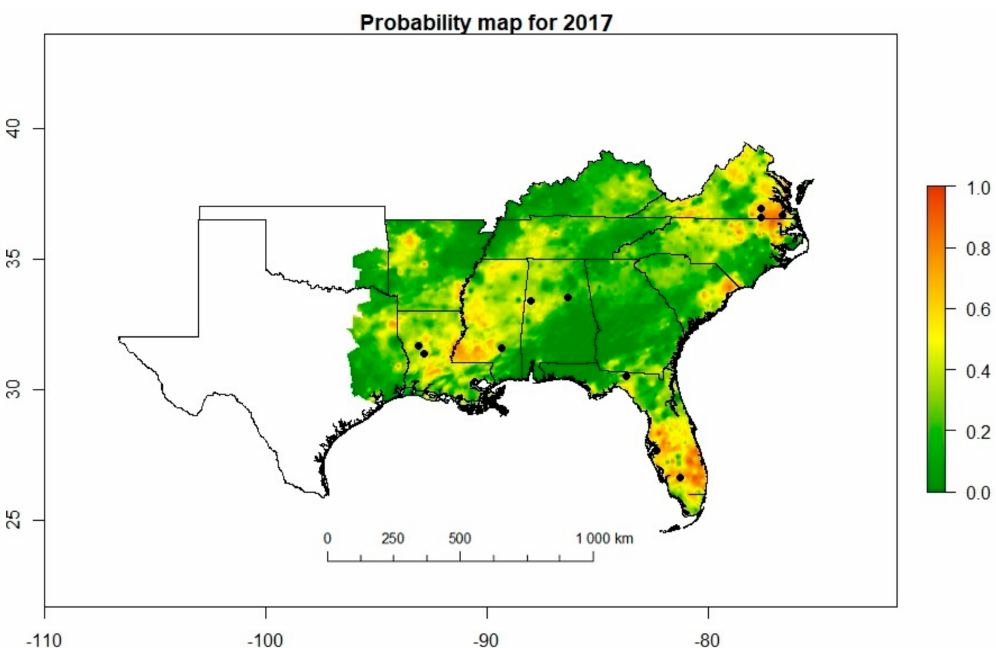
Figure 5. Probability maps for disease distribution in the study area for 2016 and 2017. Black points represent the locations of disease observed by FIA in respective years. The color scale indicates the probability of disease occurrence based on climatic correlates from the MaxEnt